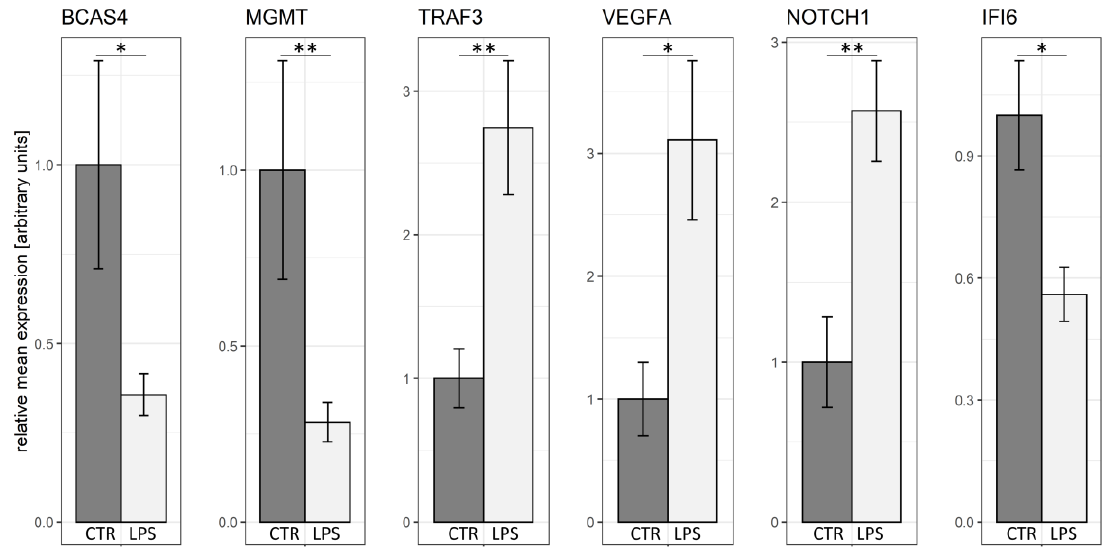
Figure 7. Real-time PCR validation of the RNA-seq results for the DEGs in the endometrial cells. Validation was performed for BCAS4, MGMT, TRAF3, VEGFA, NOTCH1 and IFI6 genes with reference genes (ACTB and PPIA). LPS—samples from the LPS-treated groups; CTR—samples from the control groups; * p -value < 0.05; ** p -value < 0.01.